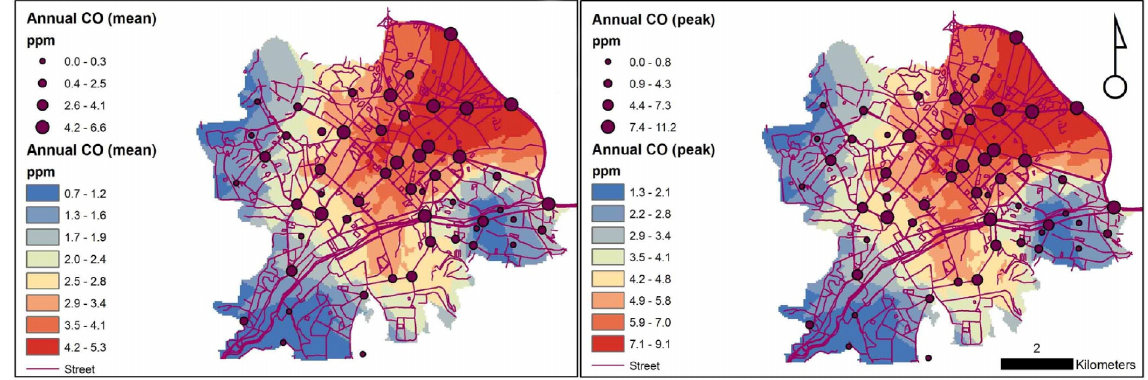
Fig. 2. Spatial pattern of annual mean and annual peak CO concentrations in Urmia, Iran The seasonal mean and peak spatial patterns were similar to the annual mean and peak patterns and did not change much over time (Figure 3).